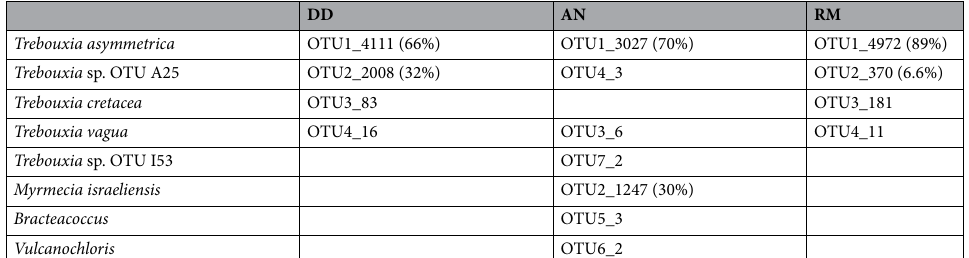
Table 1. Taxonomic identification and summary of number of sequences obtained by pyrosequencing of Trebouxia spp., Myrmecia and other minor chlorophytes for each particular OTU in the three analyzed thalli, Diploschistes diacapsis (DD), Acarospora nodulosa (AN) and Rhizocarpon malenconianum (RM). The consensus sequences of the OTUs were encoded: number of OTU_number of sequences found for this OTU. Percentage of OTU1 and OTU2 were indicate in